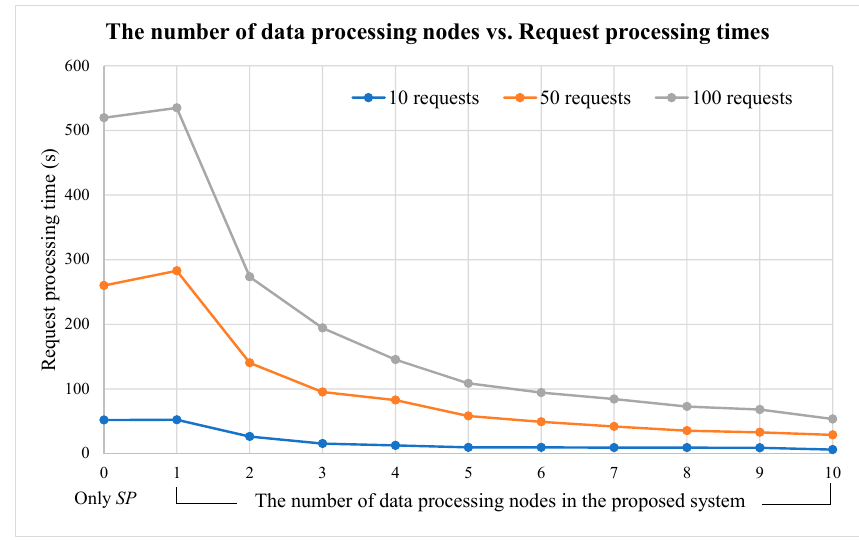
Figure 13. Number of data processing nodes vs. request processing time (only SP processes are requested when the number of data processing nodes is 0).